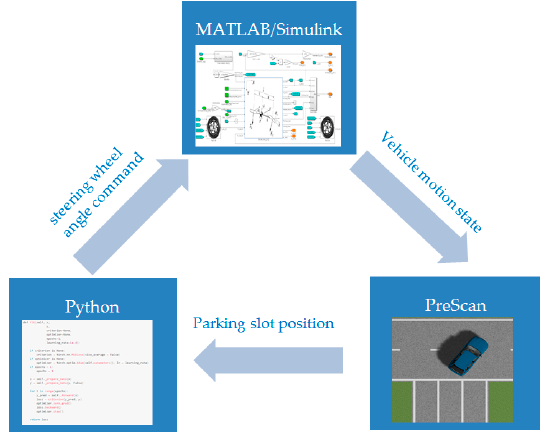
Figure 10. Simulation platform.